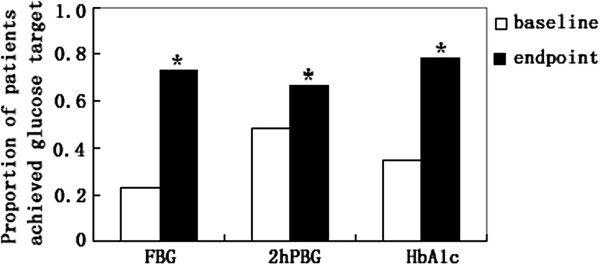
Proportion of patients who achieved clinically relevant changes in FBG (4.1–5.5 mmol/l), 2 h PBG (7.2–8.9 mmol/l), or HbA1c (< 7.0%) target at week 20. * P < 0.001 vs. baseline.